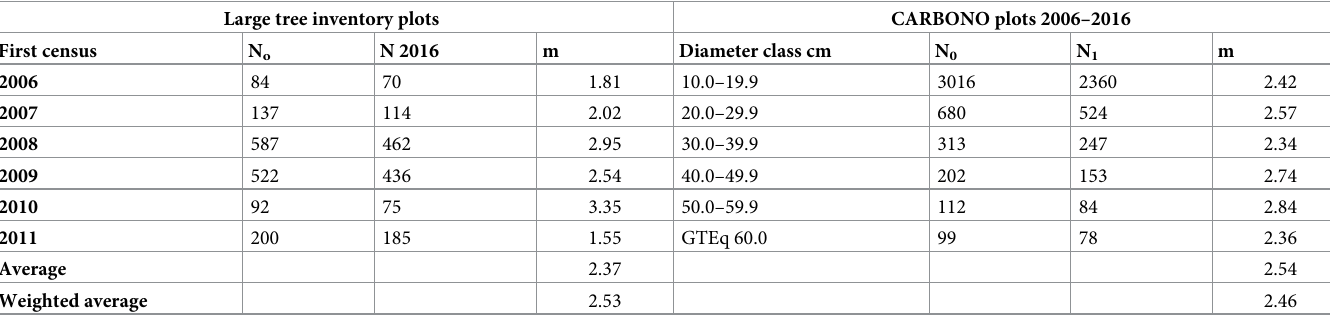
plots. For both large trees and smaller trees there were no significant differences in mortality between the flat and steeply-sloping plots on residual soils, but small stem recruitment was higher on flat residual-soil sites compared to steeply sloping ones (Table 8). In the long-term inventory plots mortality of large trees accounted for an average of 22% of the total annual basal area loss from 1997–2017 (S6 Table). Large tree basal area loss ranged from 8% to 56% of total annual basal area lost in the plots. This was more than twice as variable as annual basal area loss by smaller stems (CV 79% v 31%), so that interannual variance in landscape-scale basal area loss was primarily driven by the death of large trees. There was no relation between total basal area lost in a year by large trees and by smaller stems (r adj2 = 0.02, P = 0.53, N = 20), suggesting different causative factors for mortality in the two groups. Table 7. Tree